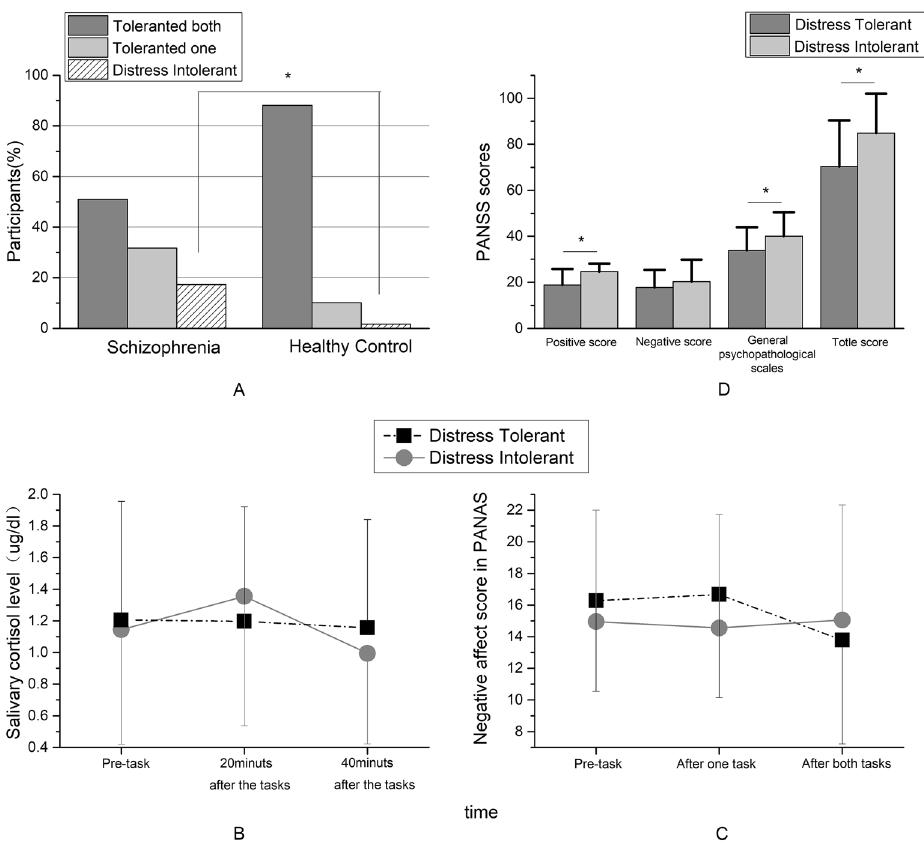
Figure 3. Analysis related to distress tolerance (* p < 0.05). ( A : comparison of task completion; B : comparison of salivary cortisol levels; C : comparison of NA scores; D : comparison of PANSS